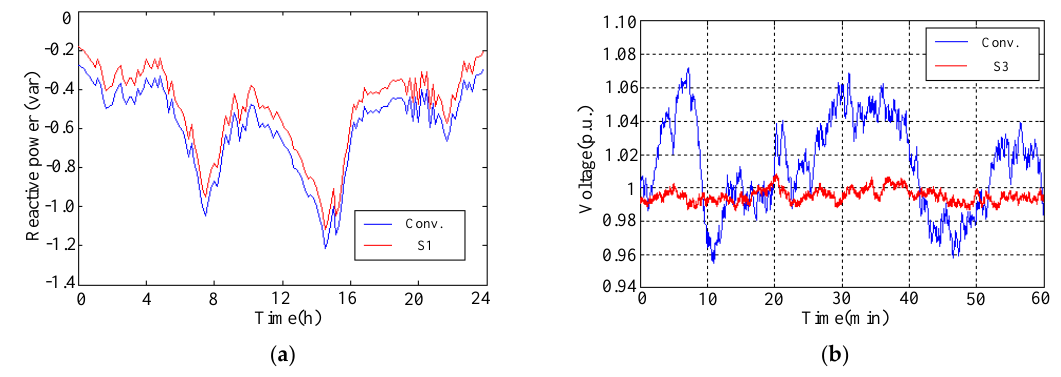
Figure 6. ( a ) Reactive power and ( b ) voltage curves at the PCC under different control methods.